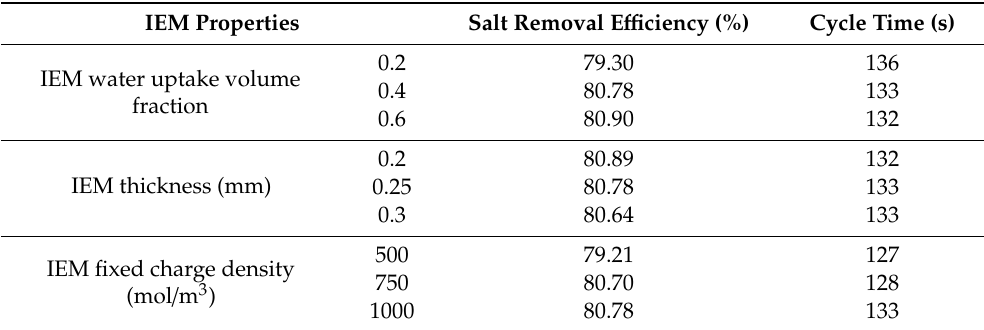
Table 4. E ff ects of the IEM water uptake volume fraction, IEM thickness, and IEM fixed charge density on the maximum salt removal e ffi ciency and the corresponding cycle time of